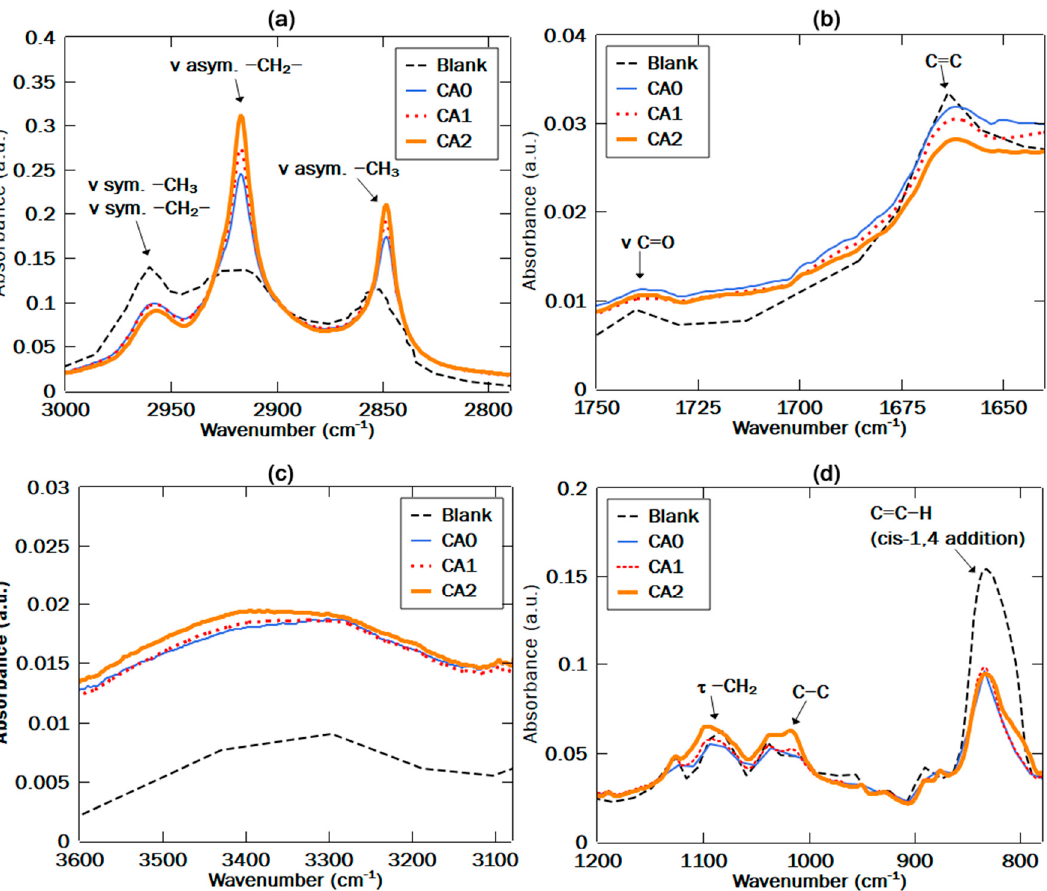
Figure 3. FTIR spectra in split wavenumber range ( a – d ) for natural (sorghum) fibers-filled in natural rubber composite, added NR-g-St coupling agent, and the Blank.